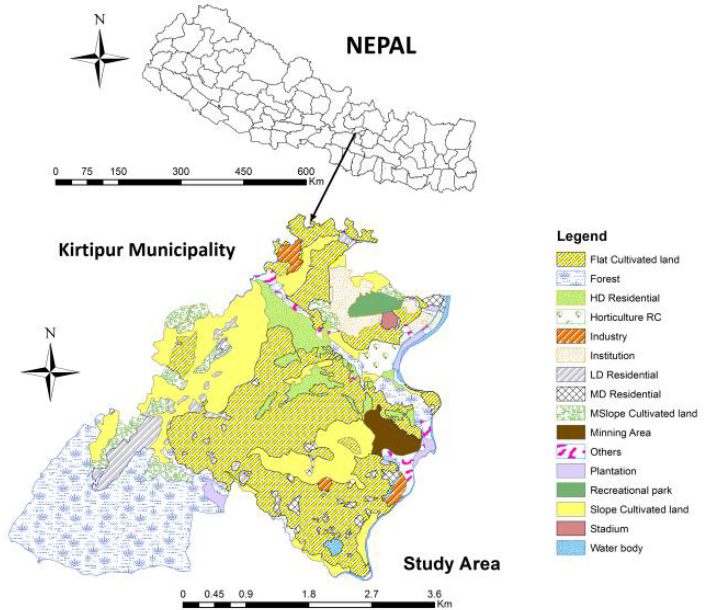
Fig. 1: Geographic location of the study area in land use types of Kirtipur Municipality, Nepal